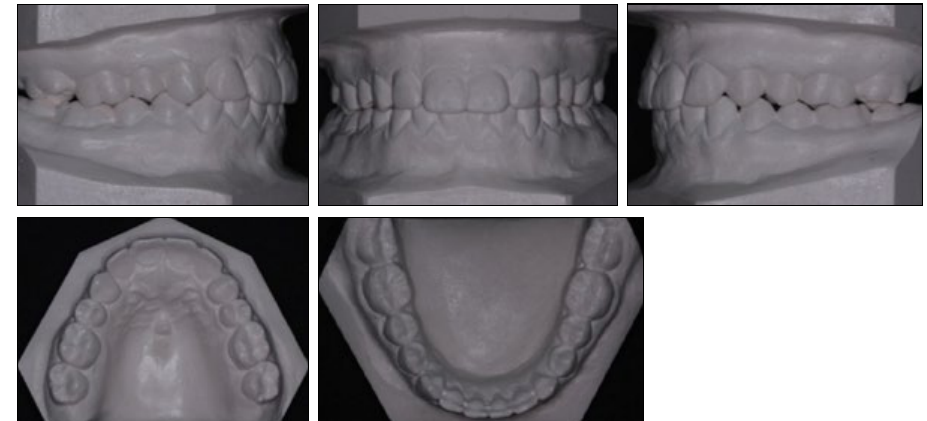
Figure 18. Photographs of dental casts after one year of retention.